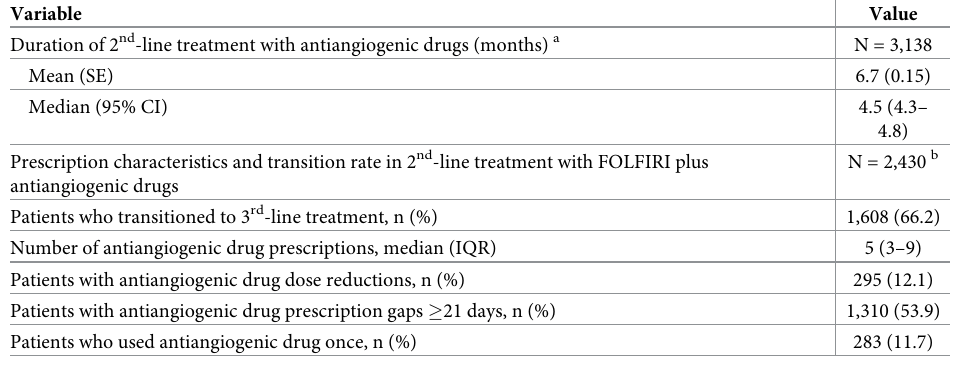
Table 3. Prescription characteristics and treatment continuation in the FOLFIRI plus antiangiogenic drug sub- population (second-line treatment). Variable Value Duration of 2 nd -line treatment with antiangiogenic drugs (months) a N = 3,138 Mean (SE) 6.7 (0.15) Median (95% CI) 4.5 (4.3– Prescription characteristics and transition rate in 2 nd -line treatment with FOLFIRI plus antiangiogenic drugs Patients who transitioned to 3 rd -line treatment, n (%) 1,608 (66.2) Number of antiangiogenic drug prescriptions, median (IQR) 5 (3–9) Patients with antiangiogenic drug dose reductions, n (%) 295 (12.1) Patients with antiangiogenic drug prescription gaps � 21 days, n (%) 1,310 (53.9) Patients who used antiangiogenic drug once, n (%) 283 (11.7) FOLFIRI, leucovorin, fluorouracil, and irinotecan; SE, standard error; CI, confidence interval; IQR, interquartile range. a Duration was estimated using the Kaplan-Meier method. The mean survival time and its standard error were underestimated because the largest observation was censored and the estimation was restricted to the largest event time. b Patients with data available � 60 days after the end of second-line therapy or patients who transitioned to third-line therapy were included in this